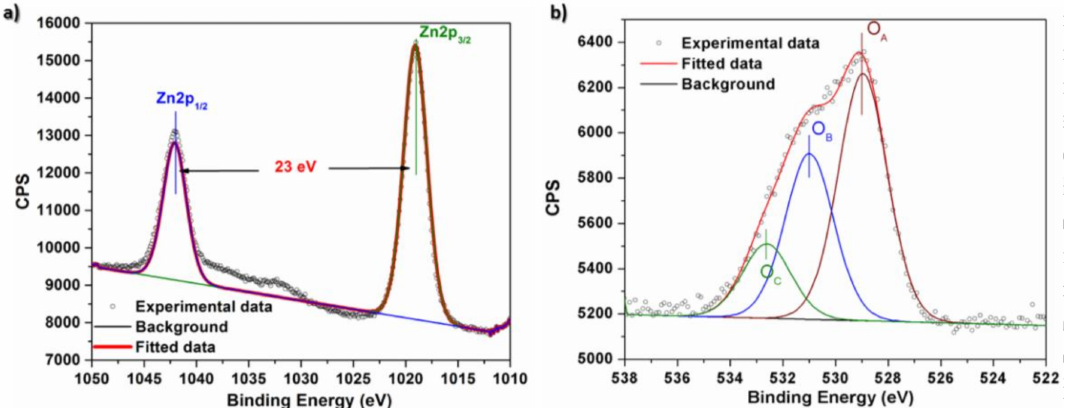
Figure 4. The high-resolution X-ray photoelectron spectroscopy (XPS) spectra of ZnO NFs ( a ) in the Zn 2p region and ( b ) the O 1s region.